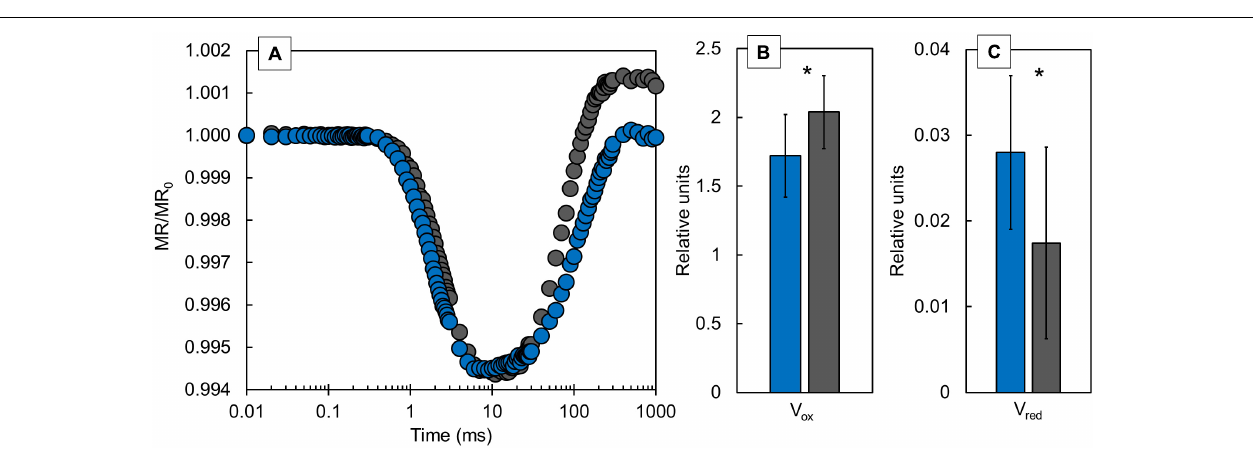
Frontiers in Plant Science |